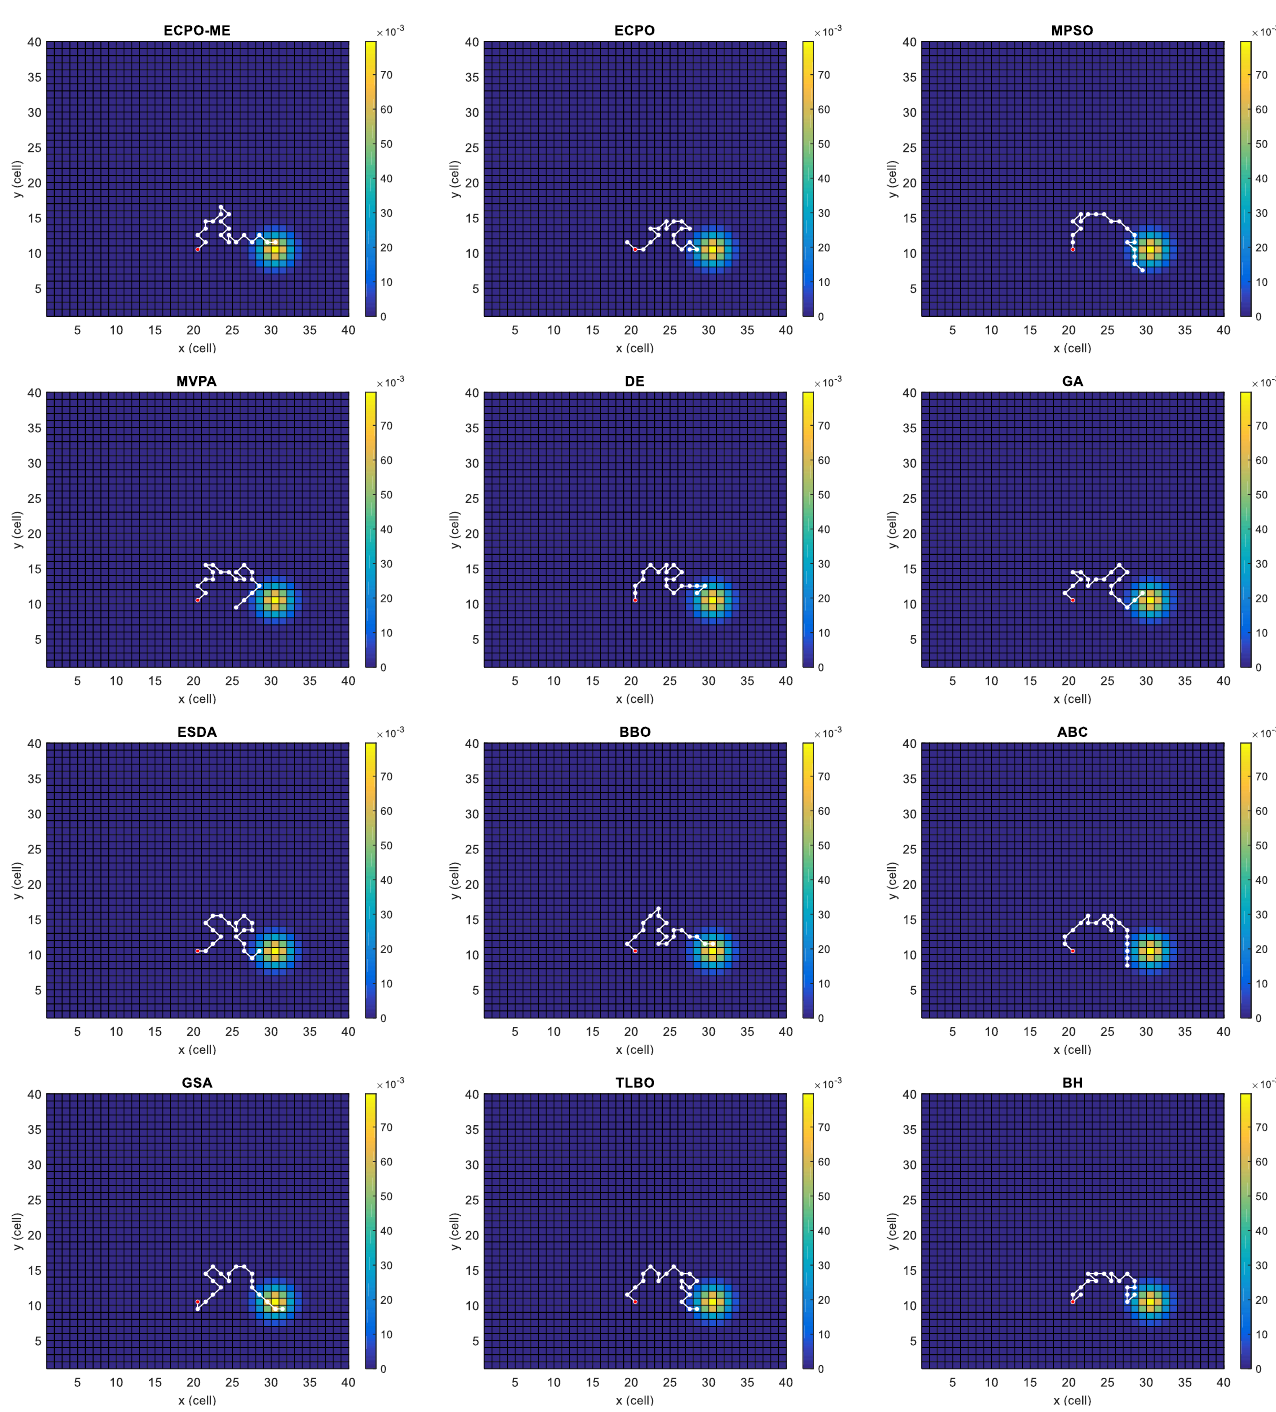
Figure 6. Search paths for Scenario C, obtained using the tested algorithms.